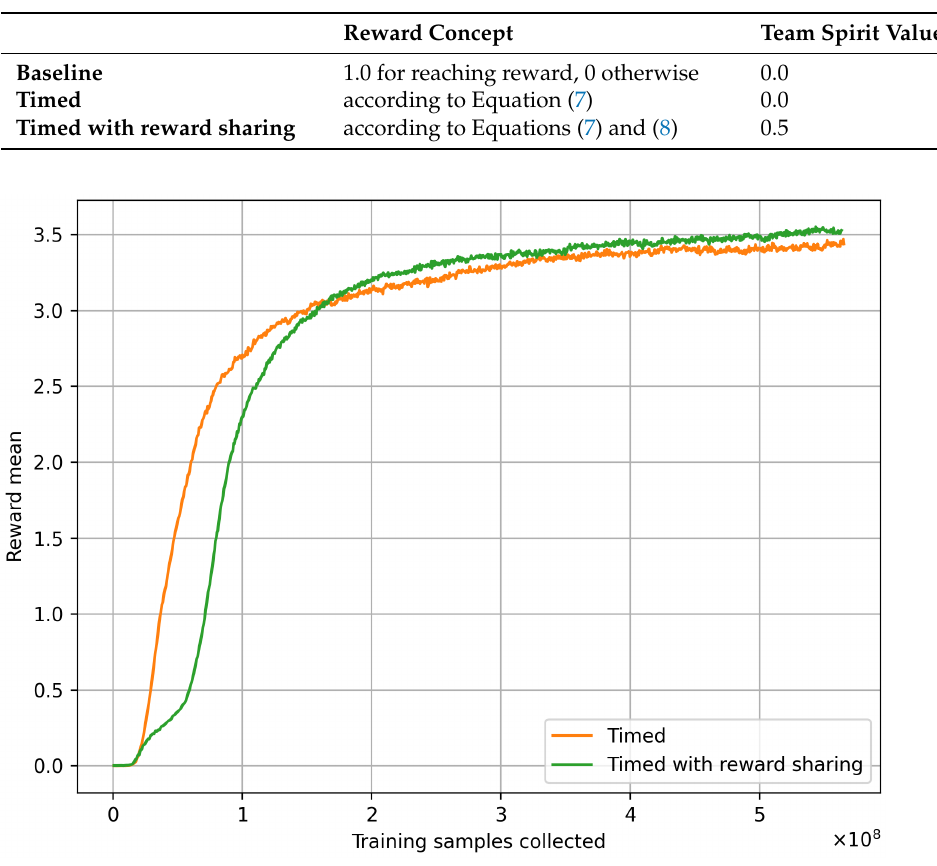
Table 3. Main configuration parameters of experiments conducted in crossroad scenarios. In Baseline and Timed experiments, team spirit is effectively set to 0.